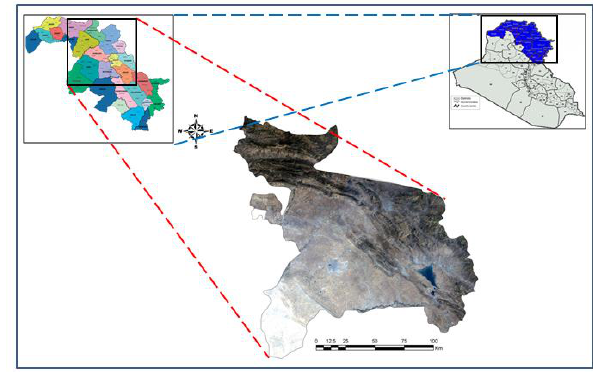
Figure 1. The location map of the study area and a Landsat RGB color composite 321 of 2012